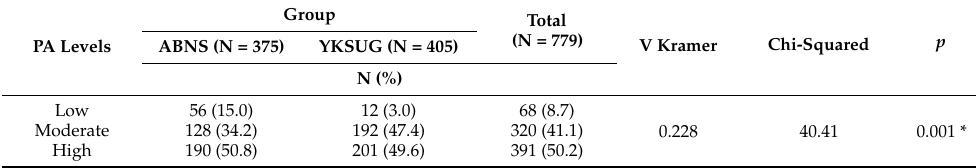
Table 3. Physical activity levels in students from Poland and Belarus (IPAQ).